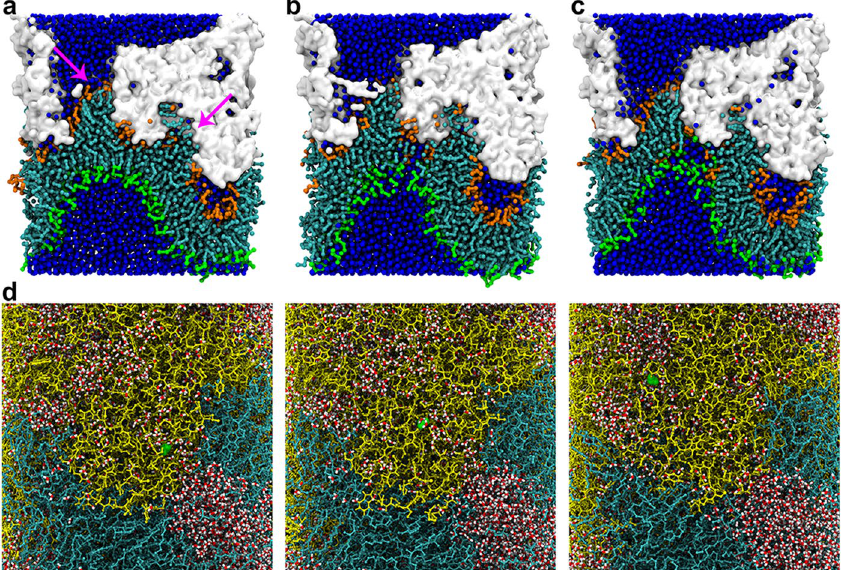
Figure 4. Process of membrane poration and water leaking. ( a–c ) Side views of the CG model of the IN membrane during the formation of a membrane pore are shown. The lipid extraction, water permeation and monolayer fusion, and pore expansion are shown sequentially from left to right. To detail the membrane changes during the poration mechanism, only the area of the simulation box that covers the membrane and the KB1 cluster are shown for each step. The lipid molecules are shown as CPK models in cyan. The head groups of the lipid molecules in the outer and inner layers are shown in orange and green, respectively. The water beads are shown as blue balls. A cluster of kB1 molecules is shown via a surface model in white. The arrows indicate two clusters of lipid molecules that are extracted from the membrane. ( d ) Side view of the AA model of the same membrane. The lipid molecules are shown as licorice models in cyan. The water molecules are shown via CPK models with white and red representing the hydrogen and oxygen atoms, respectively. The kB1 molecules in the cluster are depicted as licorice models in yellow. A water molecule represented by a green space-filling model is shown as an example of a water molecule that is leaking from the inner layer to the outer layer of the